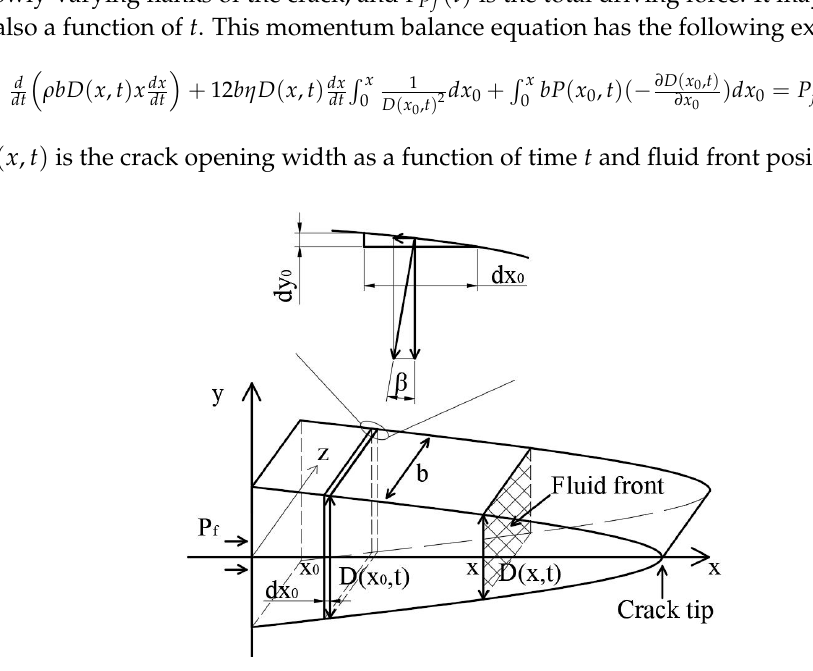
Figure 4. Illustration of dynamic fluid analyses in the crack. The coordinate origin is where the crack starts to propagate. The crack profile is assumed to stay the same while propagating. x is the position of the fluid front. x 0 is the point for the integral analyses in the fluid. D is the crack opening width. The upper part of the figure is the illustration of the analyses of the crack flank resistance.